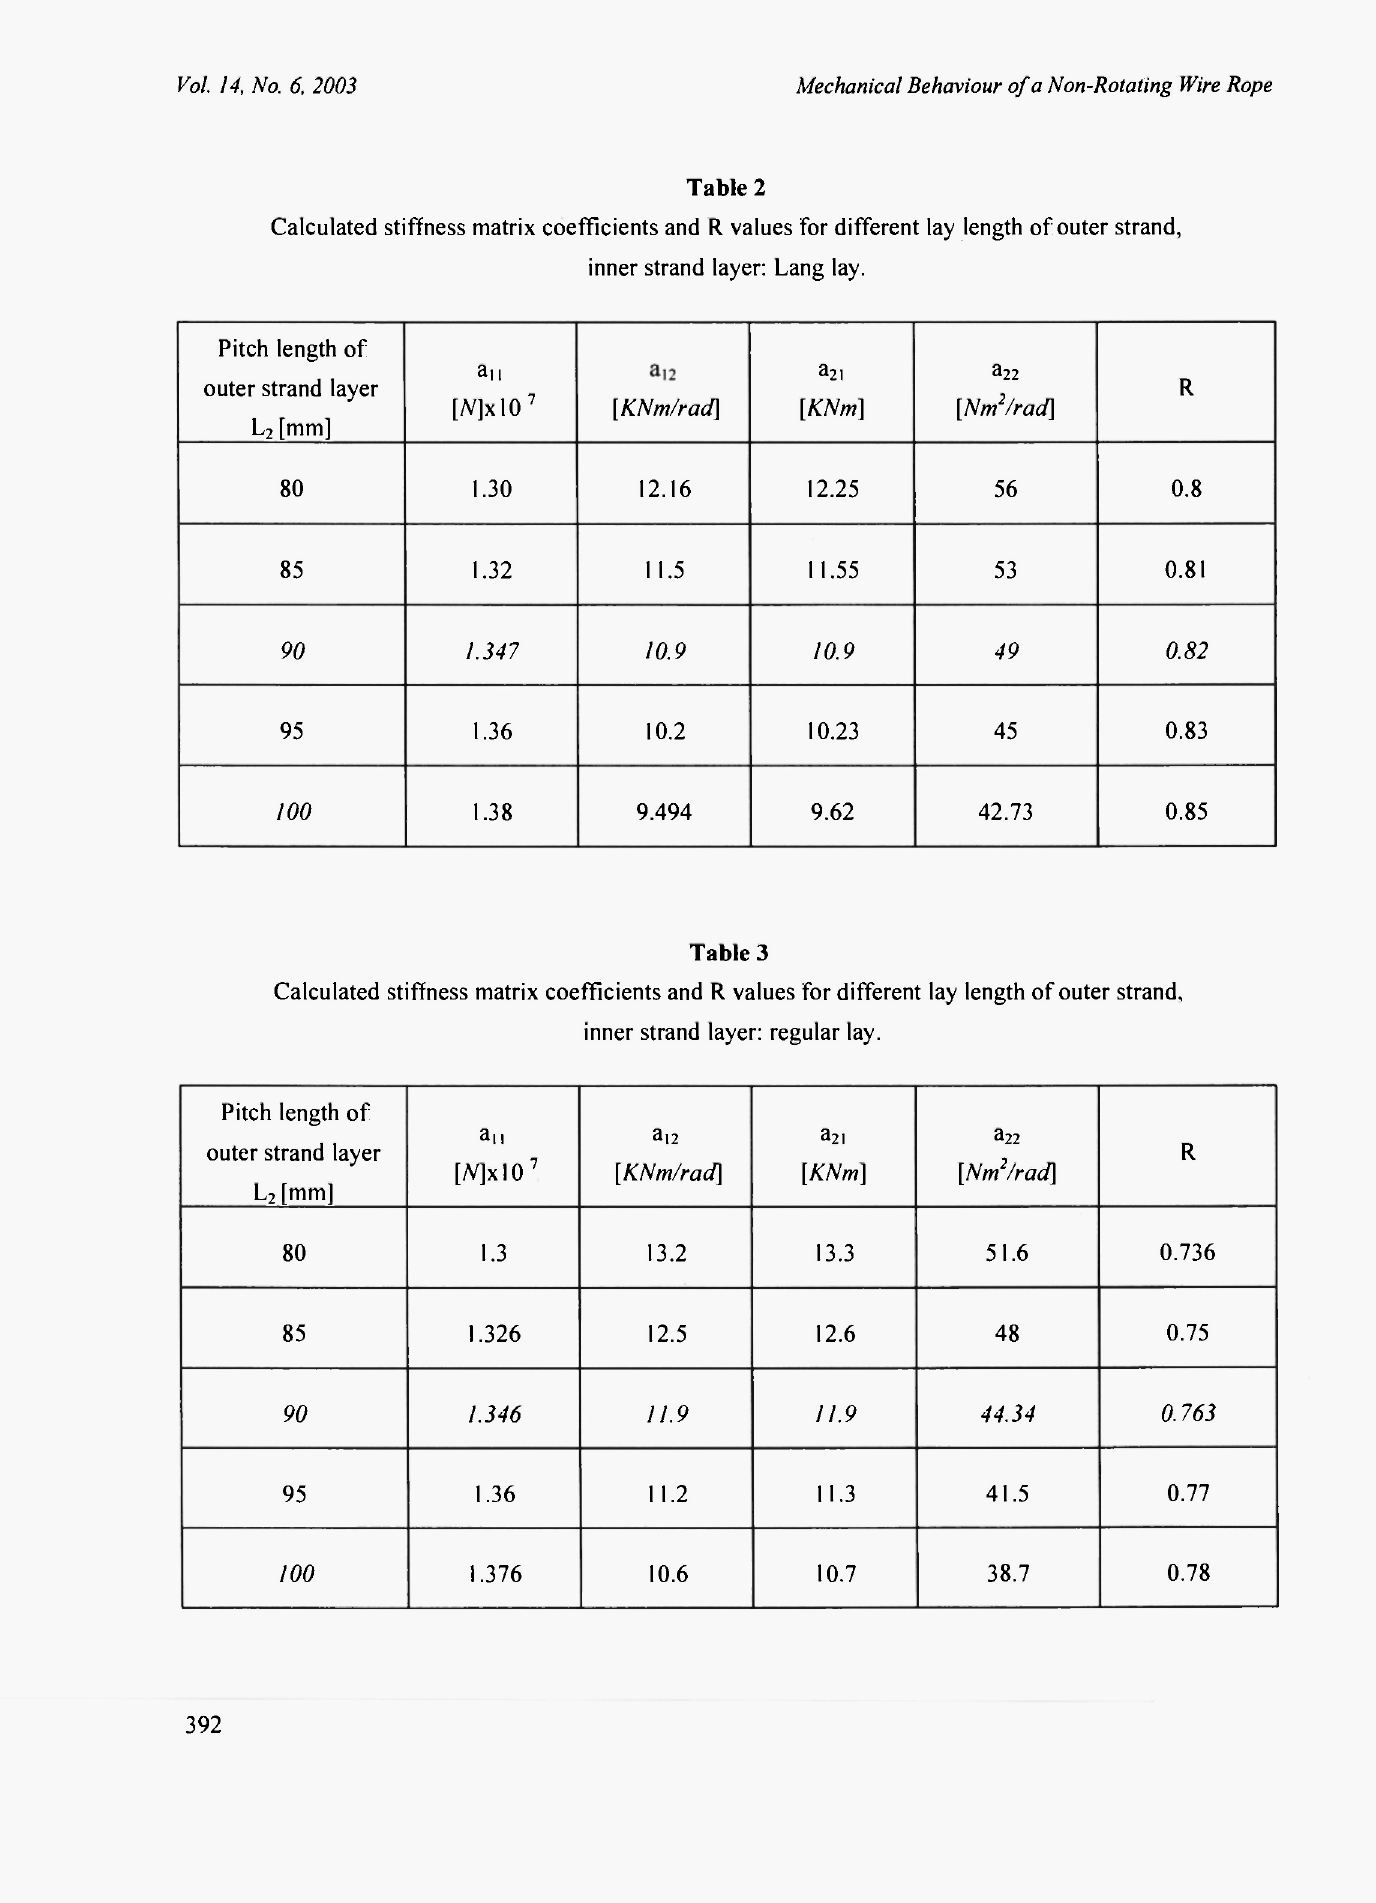
Calculated stiffness matrix coefficients and R values for different lay length of outer strand, inner strand layer: regular